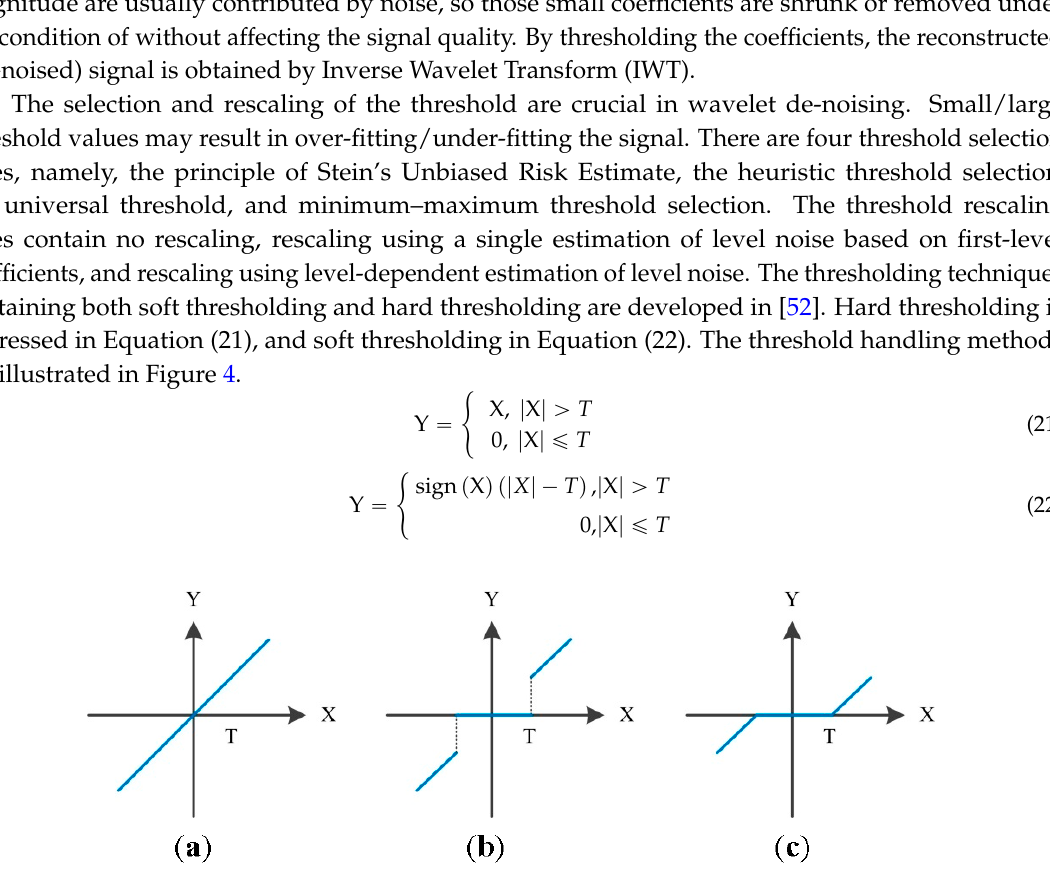
Figure 4. ( a ) Raw signal; ( b ) hard thresholding signal; and ( c ) soft thresholding signal.